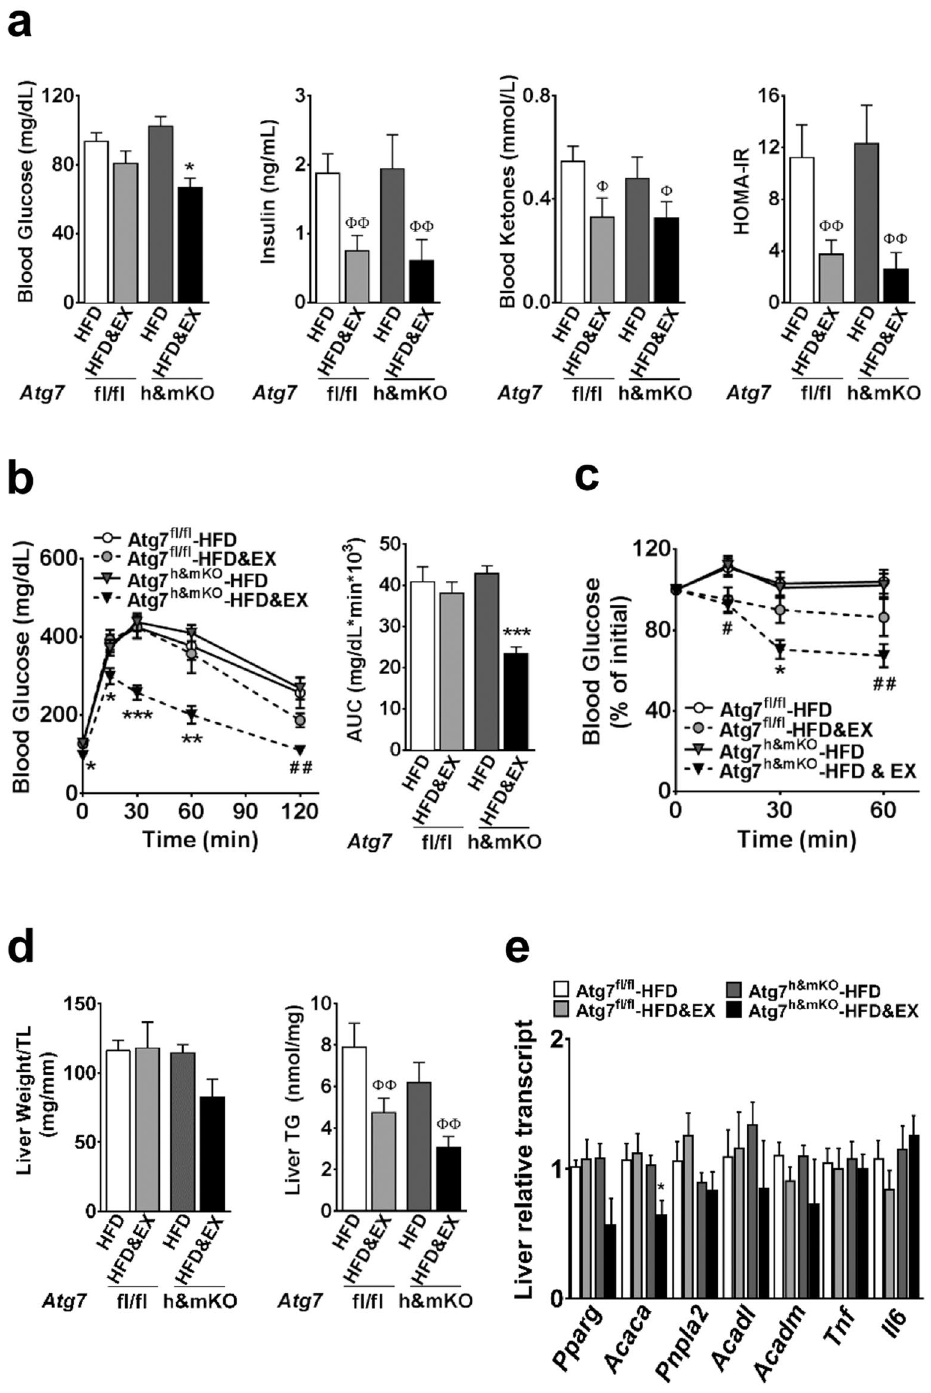
Figure 2. Improved whole-body glucose homeostasis in exercise-trained Atg7 h&mKO mice. ( a ) Overnight fasting blood levels of glucose, insulin, and ketones, and resulting HOMA-IR (n = 5–11). ( b ) GTT and respective area under the curve (AUC) (n = 8–11). ( c ) ITT (n = 8–11). ( d ) Liver mass normalized to tibia length (TL), and liver triglyceride (TG) content (n = 5–11). ( e ) mRNA of hepatic genes involved in lipid homeostasis and inflammation (n = 5–9). * P < 0.05, * * P < 0.01 and *** P < 0.001 in comparison to all other groups; # P < 0.05, ## P < 0.01 in comparison to Atg7 fl/fl -HFD and Atg7 fl/fl -HFD&EX groups; and Φ P < 0.05, ΦΦ P < 0.01 in comparison to respective HFD only, sedentary